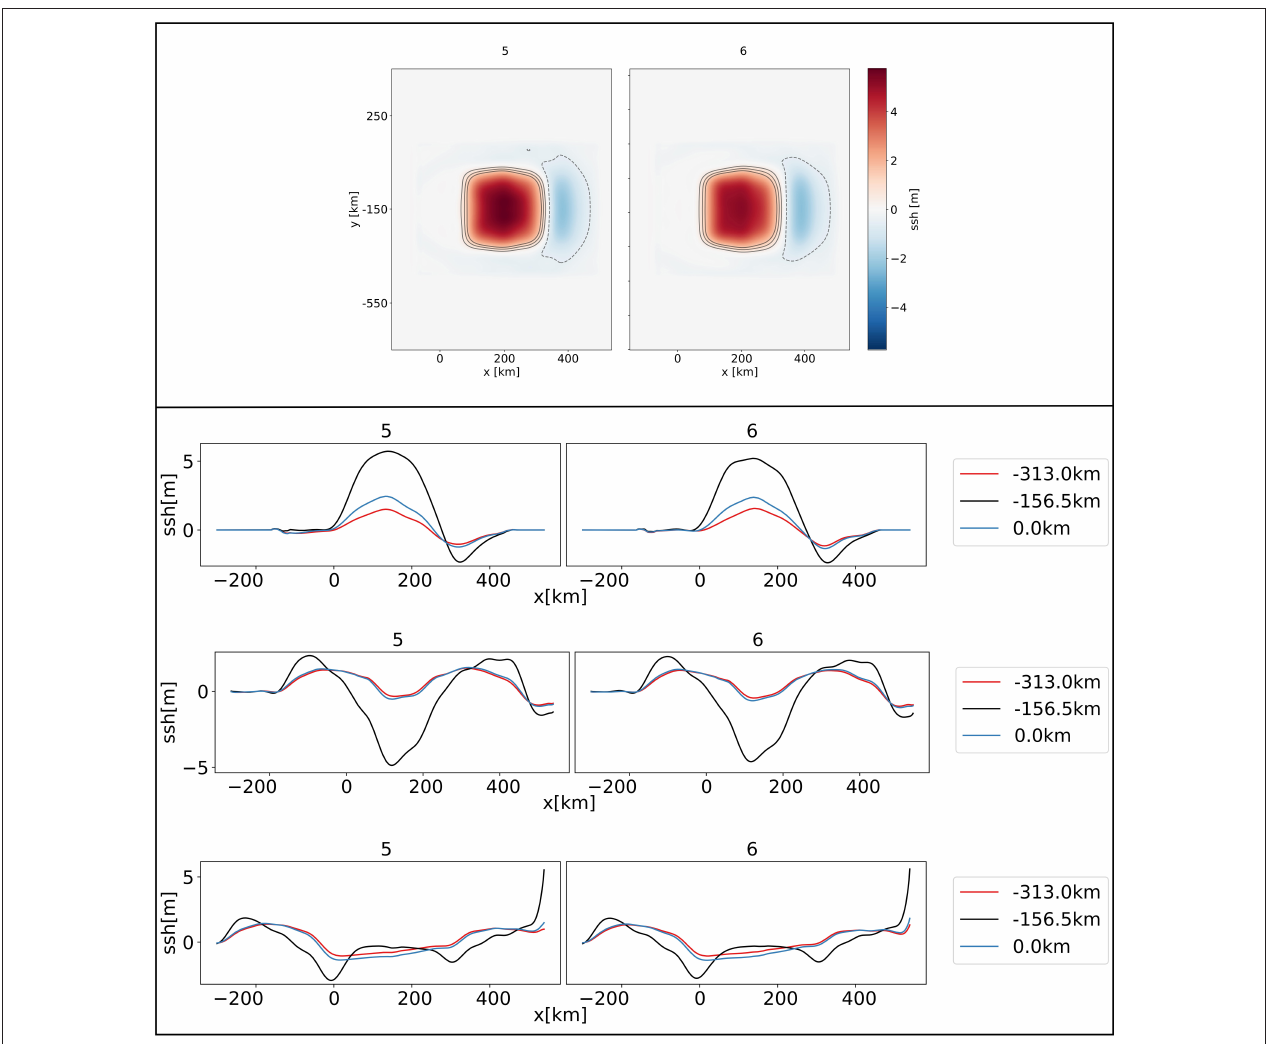
FIGURE 10 | (Top) Sea surface height (ssh) for models 5 and 6 at t = 200 s with contours at − 0.5, 0.5, 1.0, and 1.5 m, at the end of the DR earthquake simulations. (Bottom) Trajectories of the sea surface height for dynamically sourced tsunami (model 5 and 6) measured at y = 0.0, − 156.5, and − 313.0 km. Directly after the earthquake at t = 200 s (top), during the wave propagation at 1,400 s (middle), and at the time of coastal inundation at t = 2,200 s